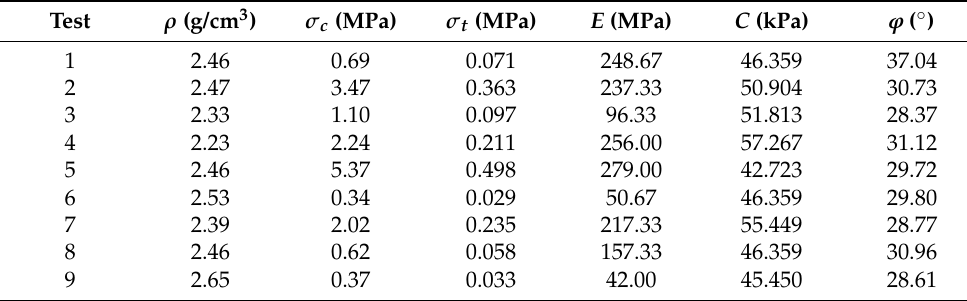
Table 3. Summary of test results.